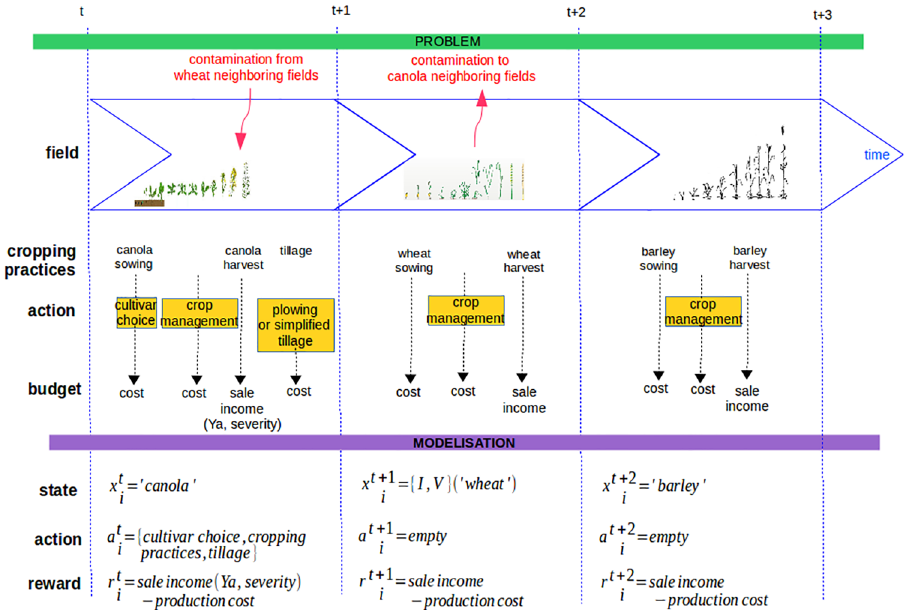
Fig 4. Representation of the succession of events that occur on a field within one year for the three considered crops.